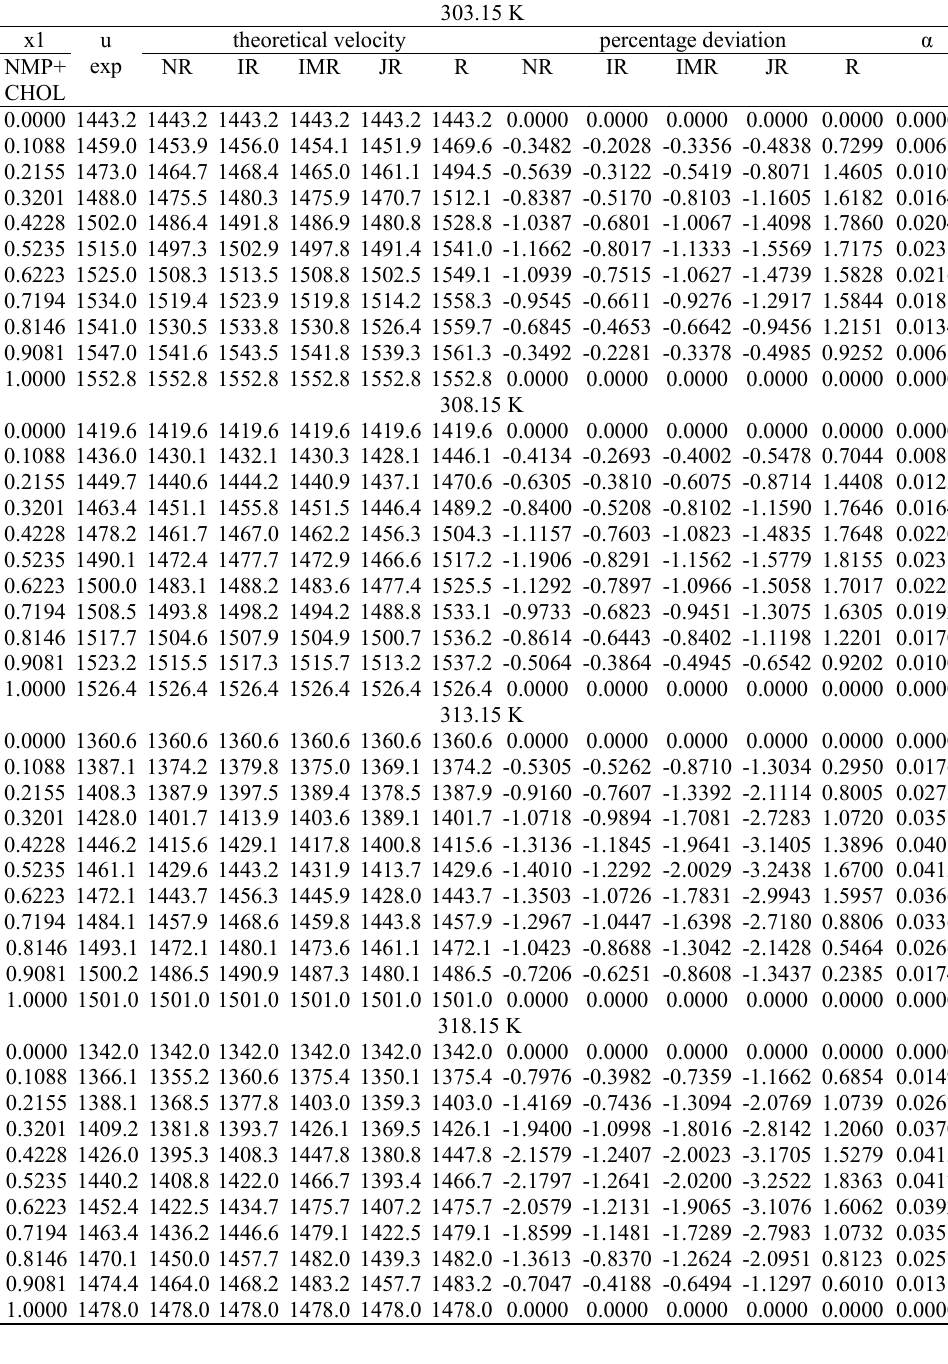
Table 2. The experimental velocity(U), the theoretical velocity, percentage deviation and molecular interaction parameter (α) for the system N -Methyl-2-pyrrolidone with cyclohexanol at different